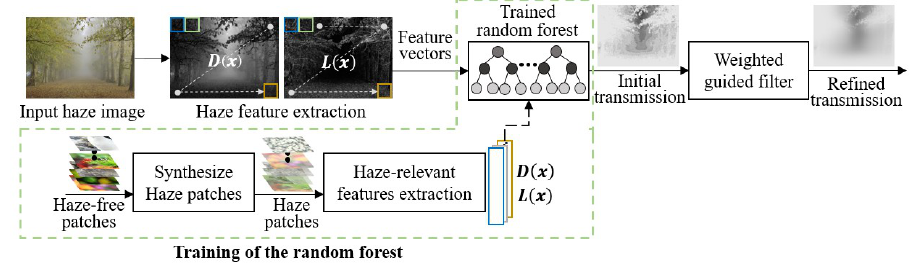
Figure 4. The proposed transmission estimation process using haze-relevant features and random forest. The green dash line shows the training of the random forest using the haze-relevant features extracted from the synthesized haze patches. In the haze feature extraction block, D ( x ) and L ( x ) represent the dark channel and local contrast, respectively.